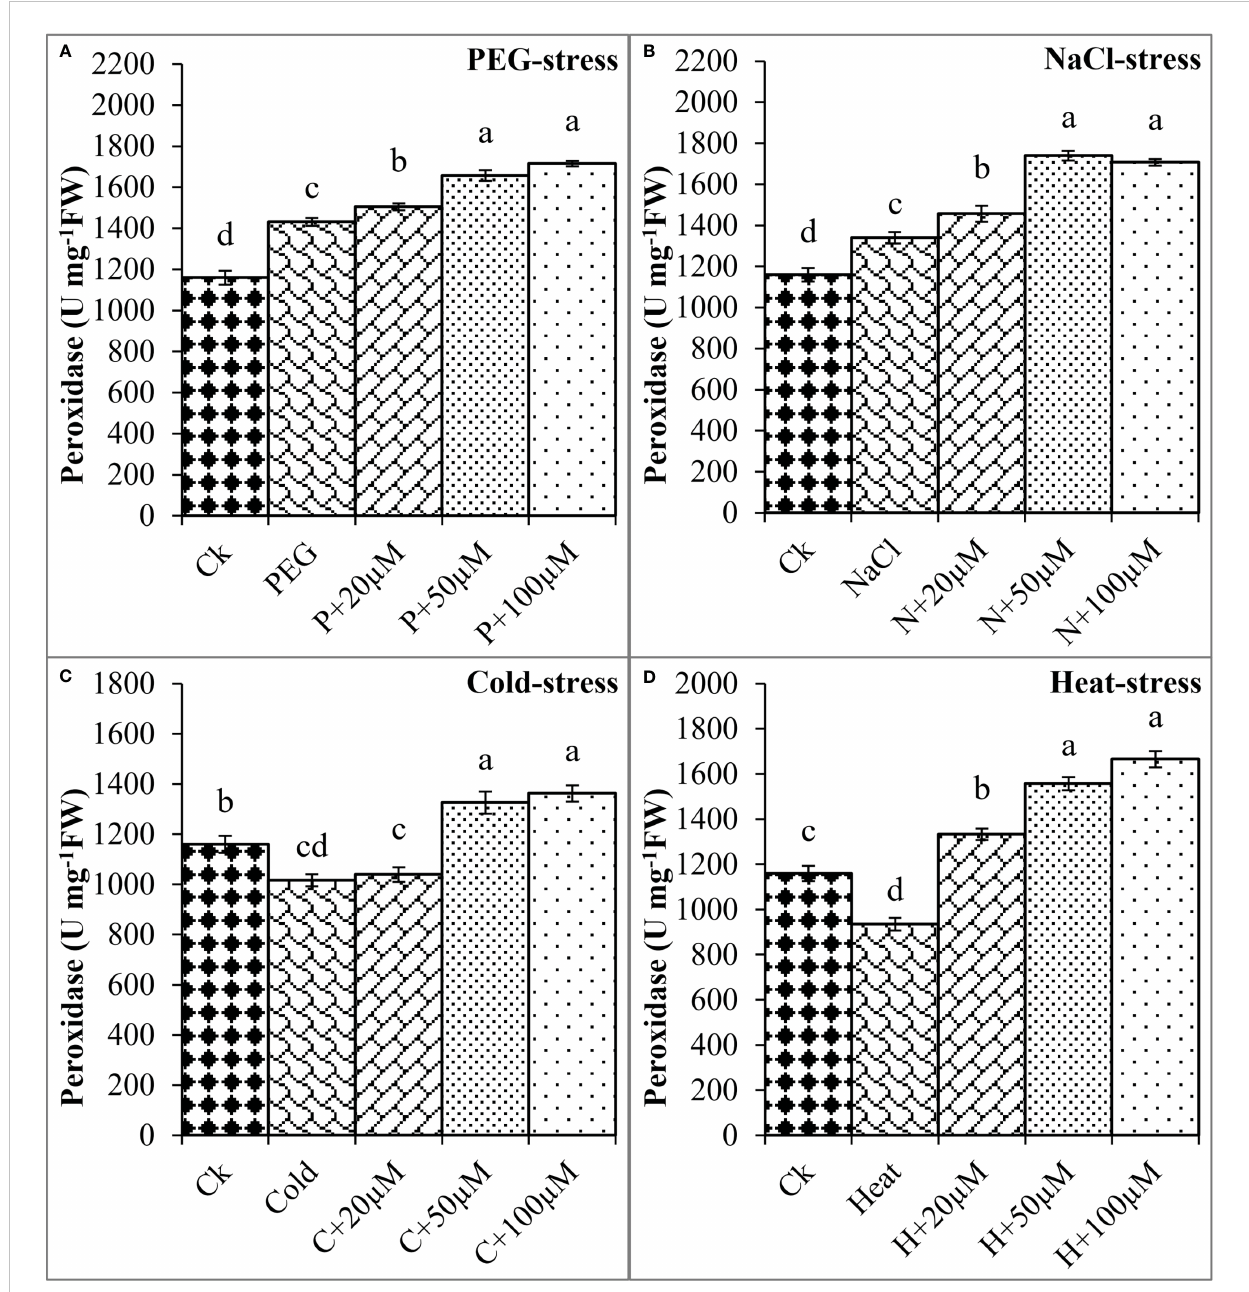
FIGURE 8 Effect of different concentrations of melatonin on the activity of Peroxidase (POD) under PEG (A) , NaCl (B) , Cold (C) , and Heat (D) . Values are the means ± SD (n=3). Different letters on the bars show a statistical signi fi cance level at p<0.05 . Here, µM is indicating (µmole L -1